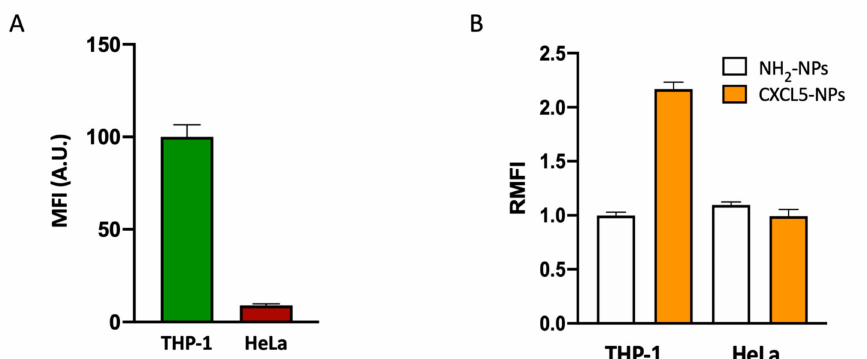
Figure 6. CXCR2 + cell preferential targeting of CXCL5-NPs. CXCR2 expression ( A ) and NPs uptake in THP-1 and HeLa cells in serum free conditions ( B ) evaluated by flow cytometry. The bars represent the median fluorescence intensity (MFI) and the relative median fluorescence intensity (RMFI) of at least three independent experiments ± standard error of the mean